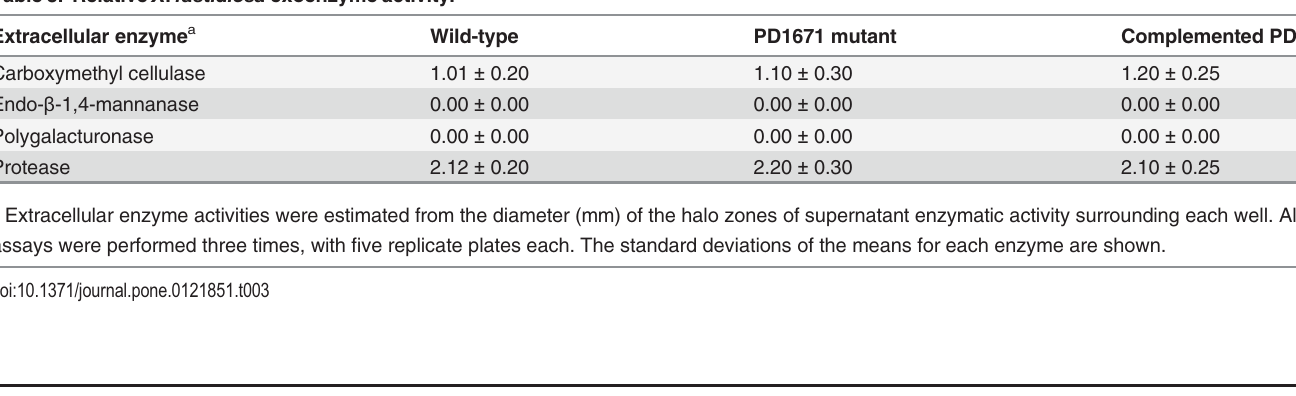
Table 3. Relative X . fastidiosa exoenzyme